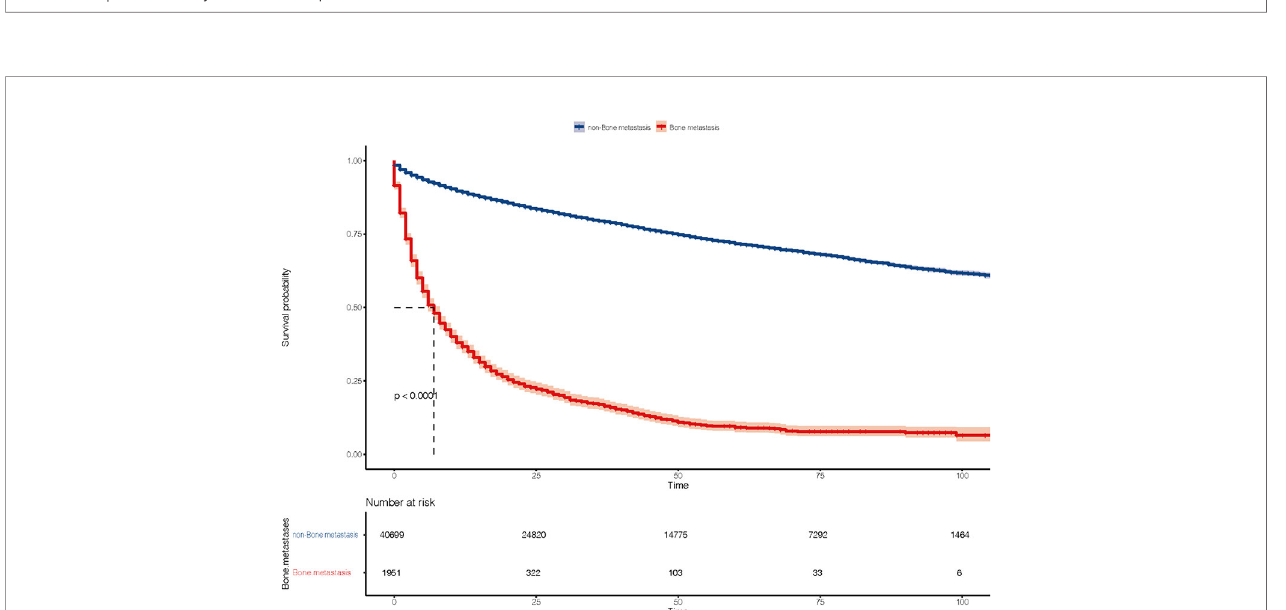
FIGURE 5 | Clinical utility curves of the predictive model.